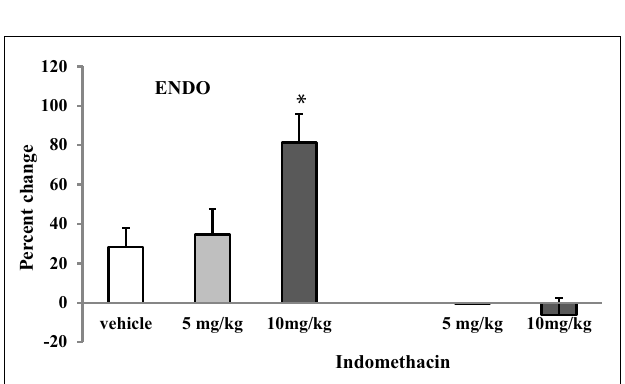
FIGURE 3 | Effects of i.p. injection of two doses of Indomethacin and vehicle on theVMR threshold in rats after ENDO or Sham ENDO surgery. Although vehicle produced a small increase in theVMR threshold, this increase was not significantly different from baseline.The increase produced by 10mg/kg of Indomethacin was significantly higher than the increase produced by vehicle. * p < 0.05 compared to vehicle.